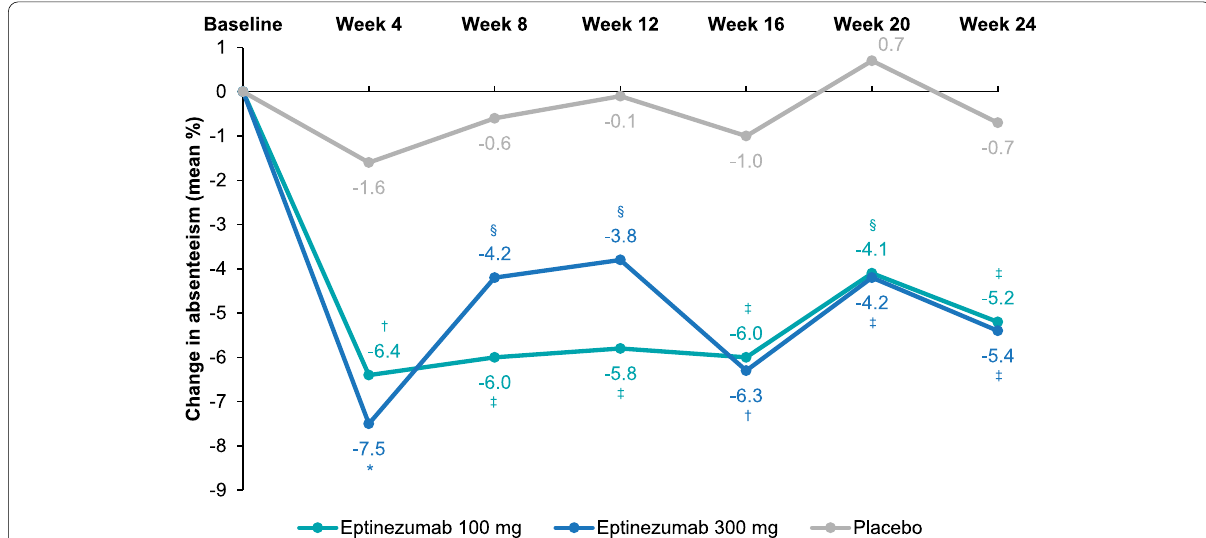
Fig. 1 Mean Changes From Baseline in WPAI:M Absenteeism Subscores. Mean changes from baseline were calculated using LSMeans from a mixed model for repeated measures. The model included the following fixed effects: visit, country, stratification factor (monthly headache days at baseline: 14/> 14) and treatment as factors, baseline WPAI:M absenteeism subscore as a continuous covariate, baseline score-by-visit interaction, ≤ treatment-by-visit interaction, and stratum by-visit interaction. * P < 0.0001 vs placebo; † P < 0.001 vs placebo; ‡ P < 0.01 vs placebo; § P < 0.05 vs placebo. WPAI:M, Work Productivity and Activity Impairment: